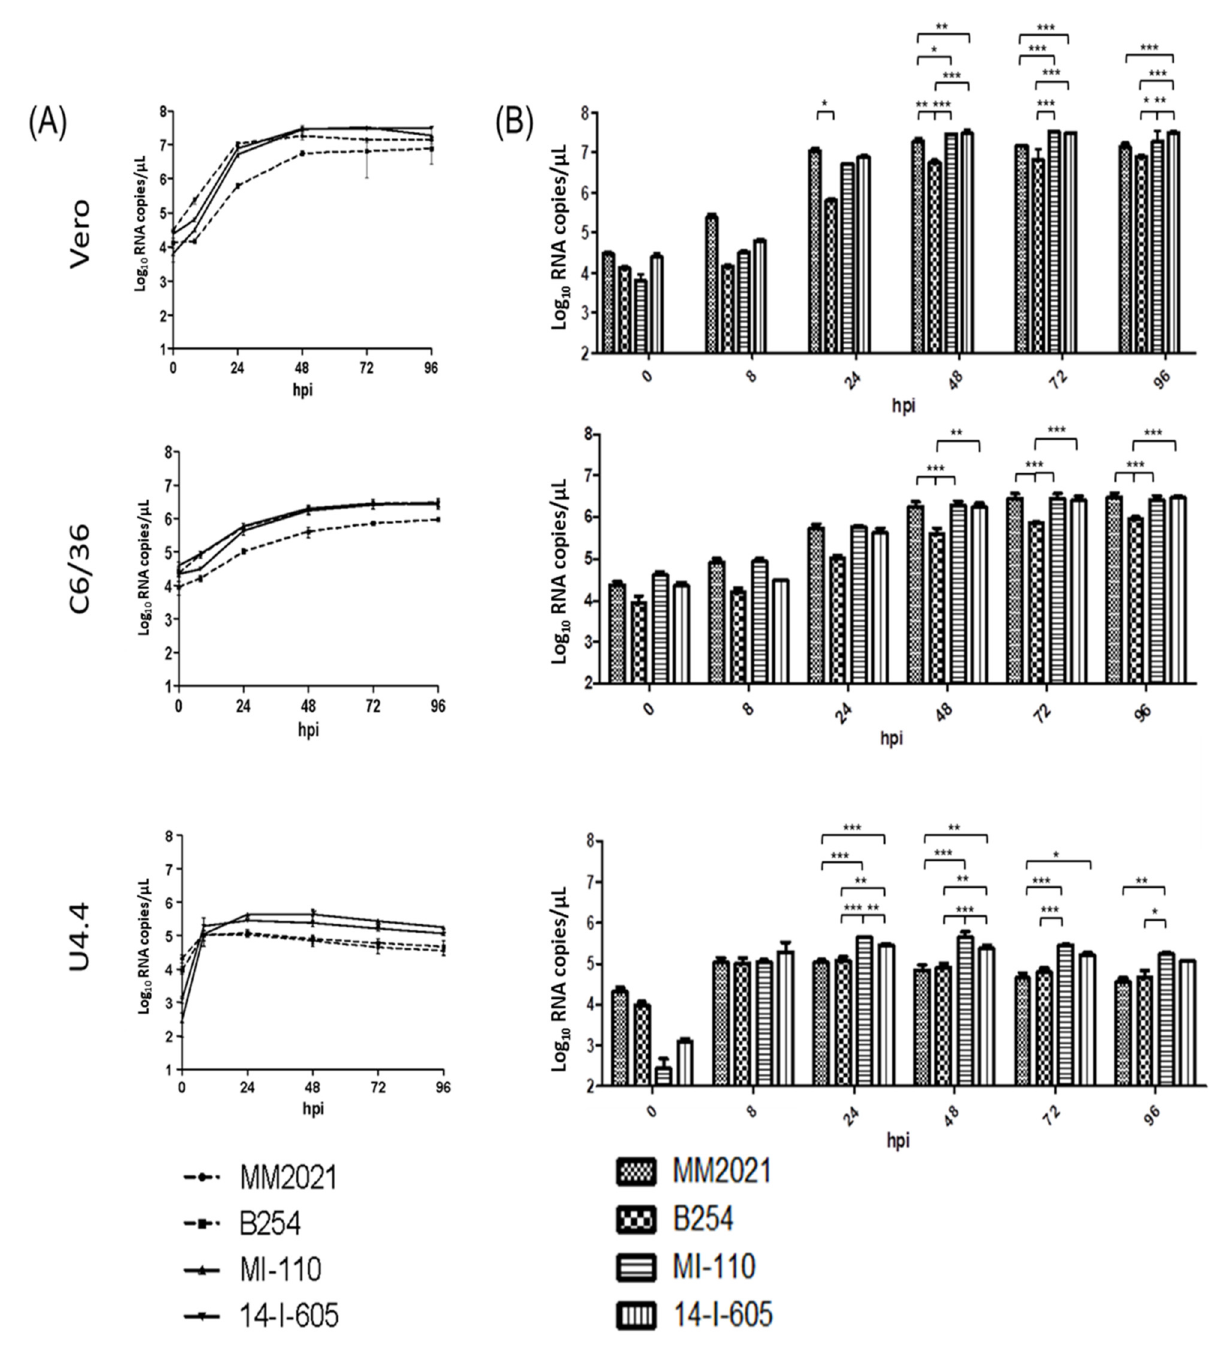
Figure 3. Replication kinetics of various GETV strains in Vero, C6/36 and U4.4 cells. Cells were infected with GETV at MOI = 0.1. Extracellular virus RNA levels at 0, 8, 24, 48, 72, and 96 hpi were quantitated using qRT-PCR. ( A ) Growth curves of different GETV strains in respective cell lines. ( B ) Bar graphs represent the growth of GETV in the cells. Data plots show the mean viral RNA copies and standard deviation (SD) of three independent replicates. Error bars indicate SD. Asterisks indicate statistical significance (* p < 0.05, ** p < 0.01, *** p < 0.001) as determined by Bonferroni test. In C6/36 cells, the virus titers of each GETV strain increased steadily over time (Figure 3A). The GIV B254 showed lower virus titer than those of GI MM2021, GIII MI- 110, and GIII 14-I-605 throughout the infection (Figure 3B), with significant differences observed at 48 hpi onwards (Bonferroni posttest, p < 0.01). The GI MM2021, GIII